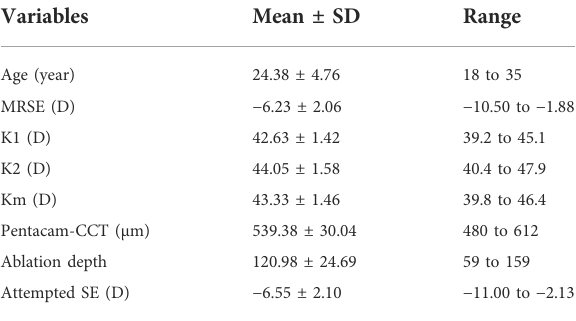
FIGURE 2 Decreases in IOP NCT, IOP GAT , IOPg, and IOPcc. Each of the changes in IOP differed from the other three IOPs (all p <